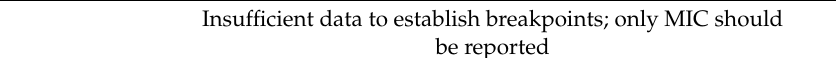
Table 3. Antimicrobial agents and susceptibility breakpoints (MICs) for testing rapidly growing mycobacteria.